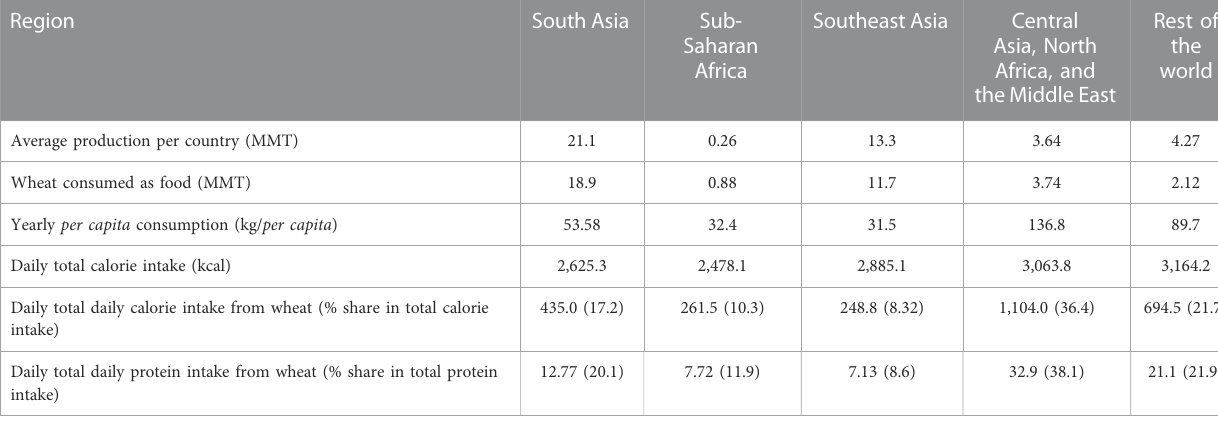
TABLE 4 Importance of wheat in the sampled regions. Region South Asia Sub-